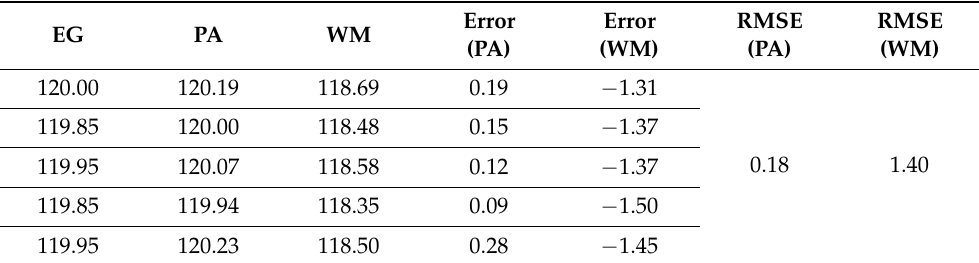
Table 6. RMSE ( ◦ ) of the joint angle (third